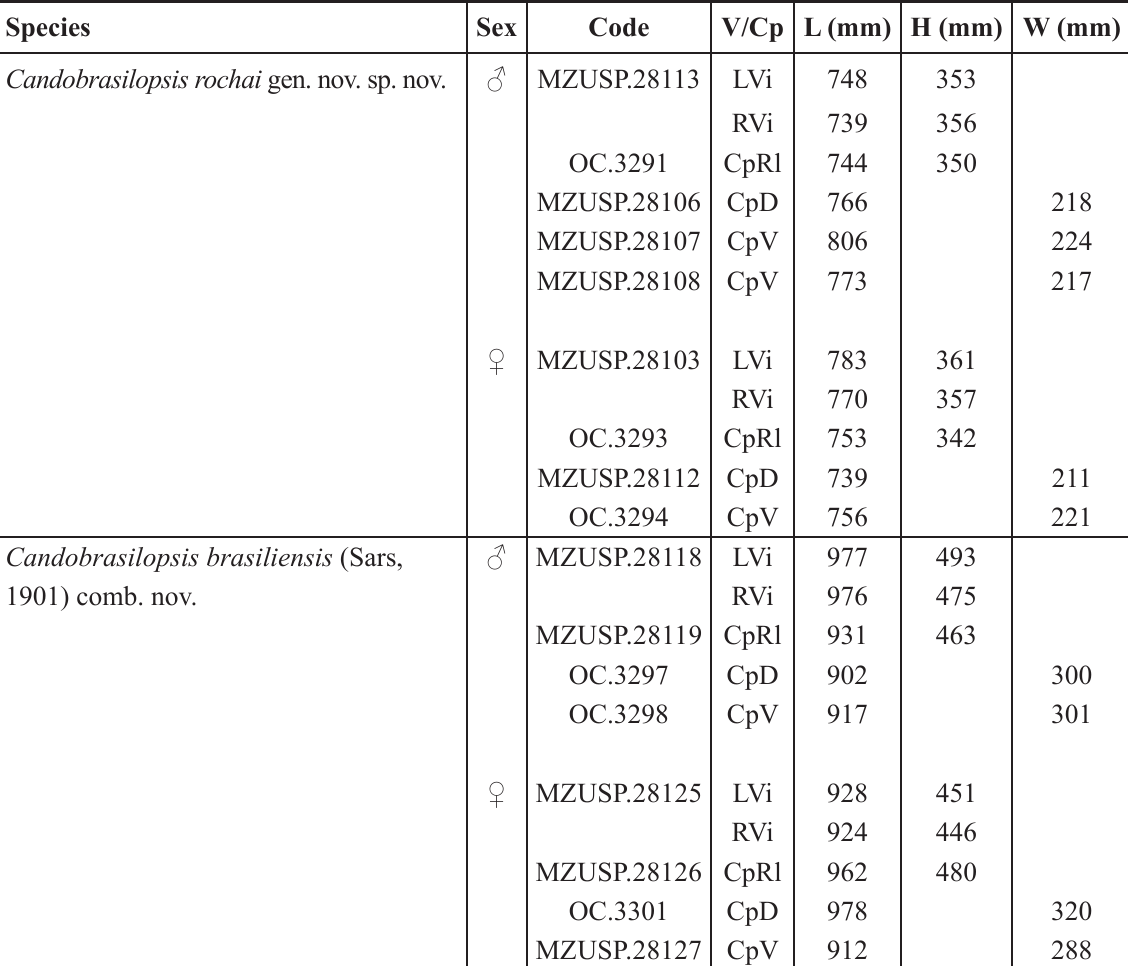
Table 3. Measurements of illustrated specimens of Candobrasilopsis rochai gen. nov. sp. nov. and Candobrasilopsis brasiliensis (Sars, 1901) comb.